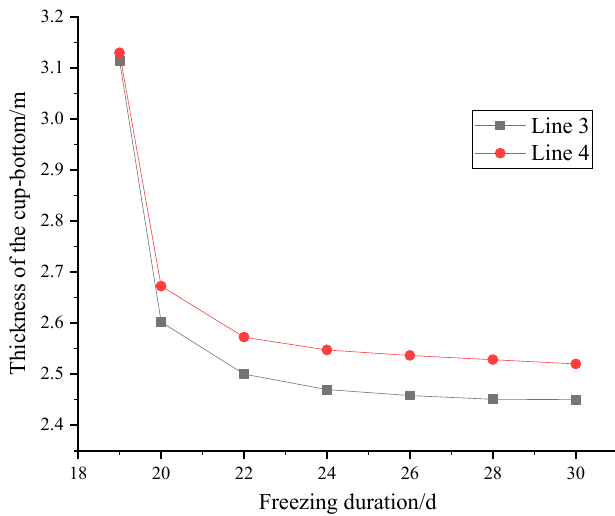
Figure 13. The bottom thickness of the cup-shaped frozen curtain. rule at the bottom, the freezing curtain melts rapidly as the shield machine enters on the 19th– 20th day. The thickness of frozen soil curtain also reached a relatively stable value on approx- imately the 26th day. The thickness of reference line 5 is 0.79 m. The thickness of reference line 6 is 0.80 m, and the thickness of reference line 7 is 0.74 m.